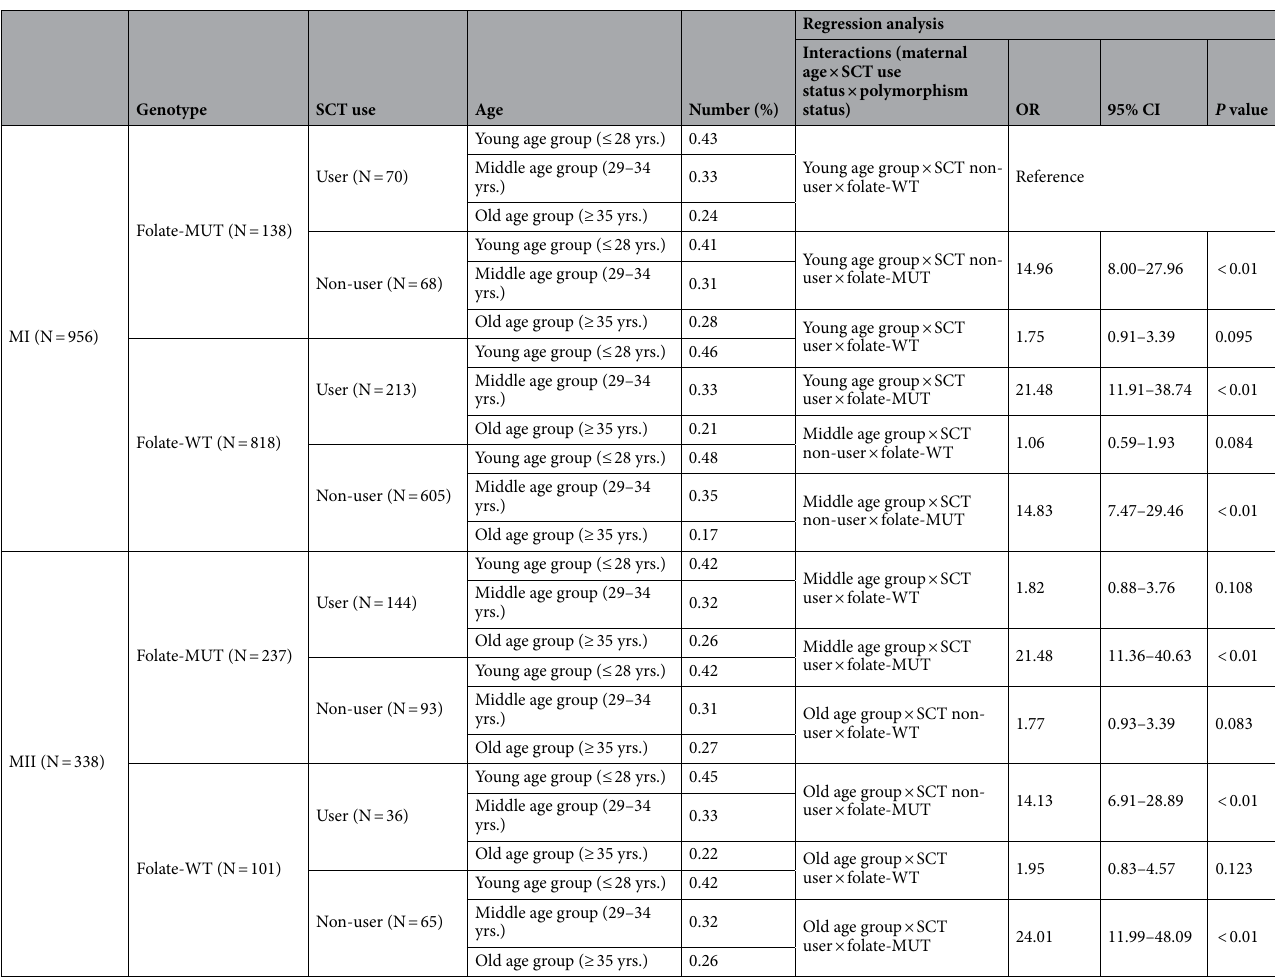
Table 4. Distribution of case women stratified by meiotic errors, folate regulator genotypes, SCT use status and maternal age at conception showing interactions among various risk factors and their association with MI and MII error groups. Binary logistic regression analysis was performed considering maternal age, SCT use status and Folate regulator genotype as predictor variables and types of meiotic errors as outcome variable to find out the association of genotype with MI or MII and P value < 0.05 is considered statistically significant. MI Meiosis I, MII Meiosis II, N number of individuals, OR odd ratio, CI confidence interval, Folate-WT folate wild-type genotype, Folate-MUT folate polymorphic/mutant risk